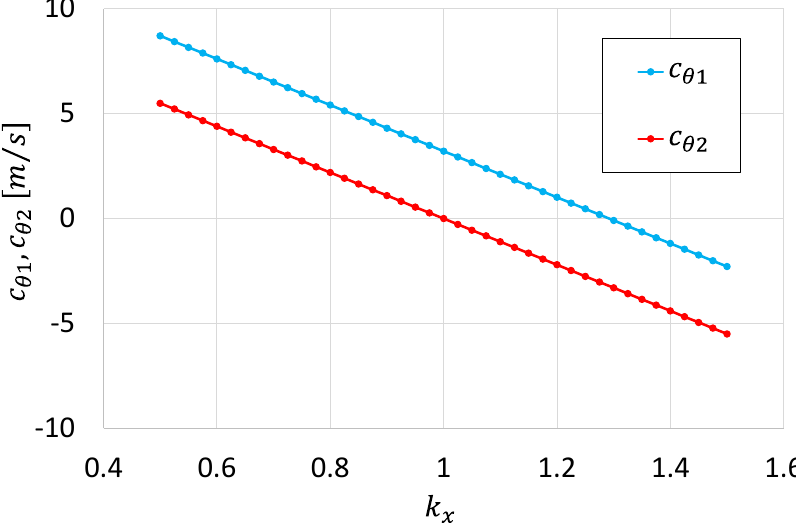
Figure 6. Tangential velocity components c θ 1 , c θ 2 . Case k u = 1 (simple guide vane regulation).